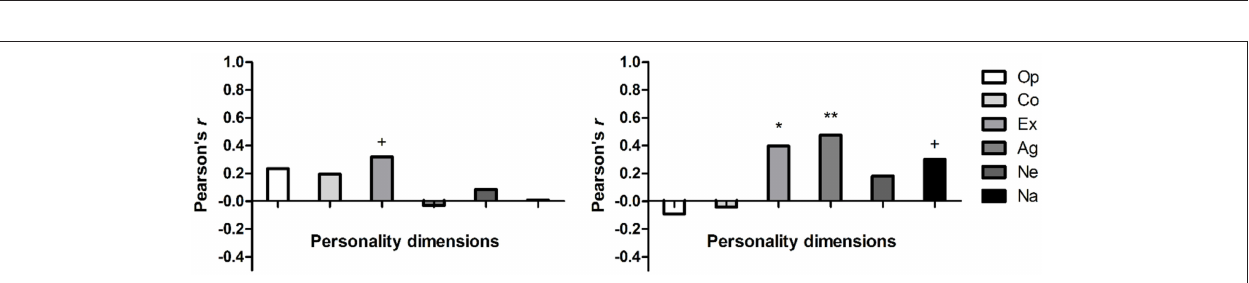
FIGURE 3 | Correlation coefficients between nickname users’ self-reported personality dimensions and participants’ personality judgments based on nicknames: intersexual (left: women rating men, right: men rating women). Op, Openness to experience; Co, Conscientiousness; Ex, Extraversion; Ag, Agreeableness; Ne, Neuroticism; Na, Narcissism. + p < 0.10, * p < 0.05, ** p < 0.01.